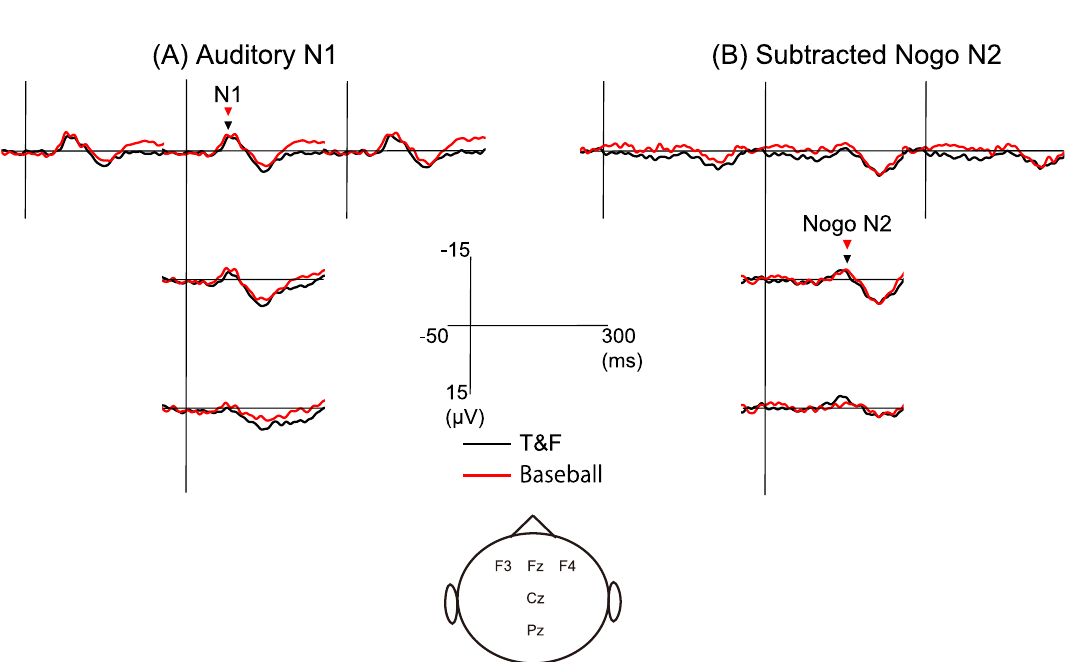
Figure 2. Grand averaged auditory N1 and subtracted Nogo N2. Grand averaged auditory N1 for Go trials ( A ) and subtracted Nogo potentials ( B ) in the T&F and baseball groups. The black and red triangles show the peak latency of each component in the T&F and baseball groups, respectively.